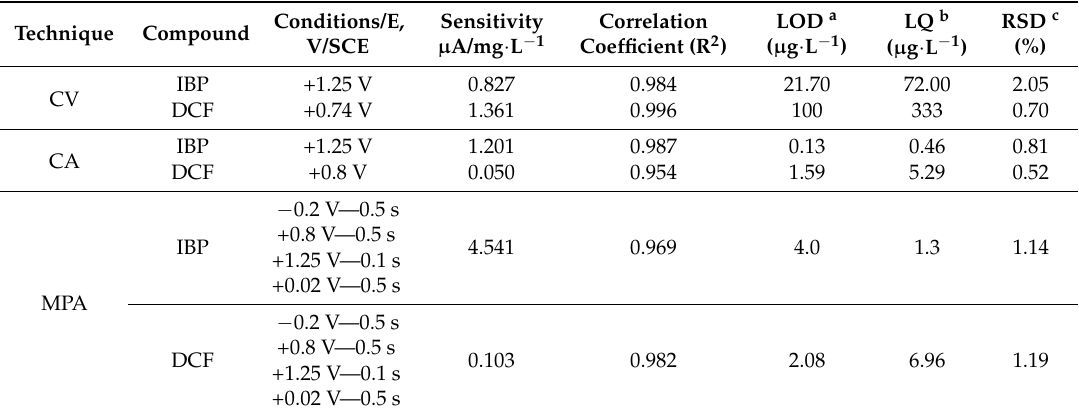
Table 1. The electroanalytical parameters reached for the individual detection of IBP and DCF with HKUST-CNF electrode.